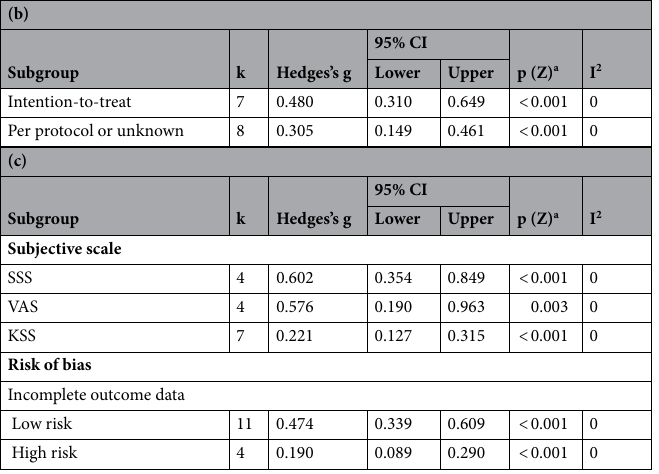
Table 5. Moderators of light treatment effect on sleepiness by using subgroup analyses with mixed-effects models. a P value for the Z test of the moderator